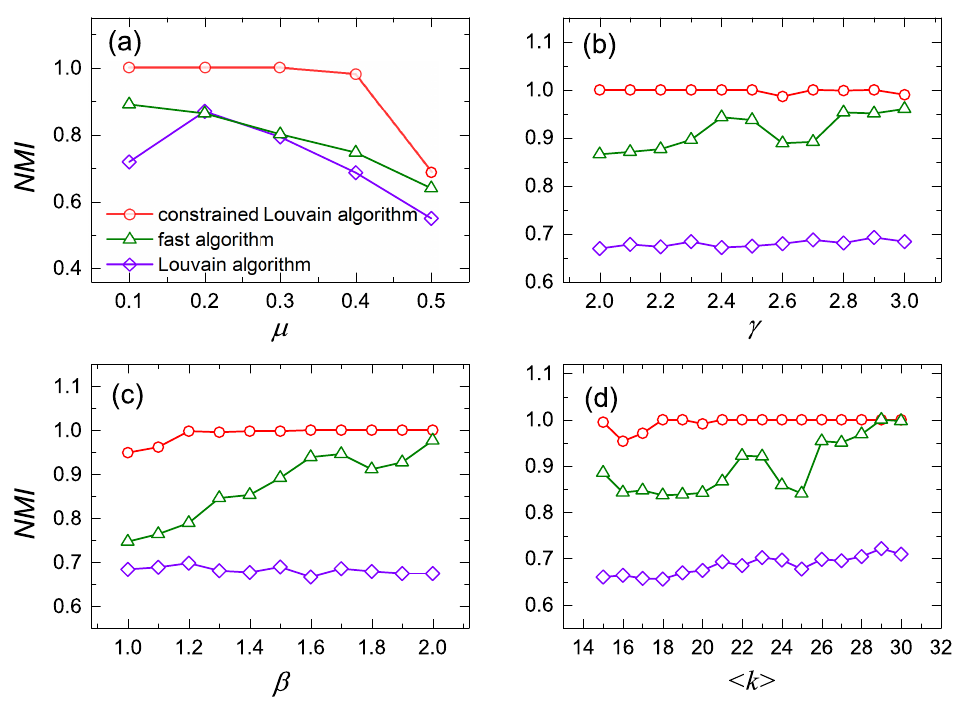
Figure 3. The NMI values of the constrained Louvain algorithm with F 2, the classical Louvain algorithm with F 2 and the Newman’s fast algorithm averaged on the 100 LFR networks with N = 1000. ( a ) µ is changed when γ = 2.5, β = 1.5 and (cid:104) k (cid:105) = 20. ( b ) γ is changed when µ = 0.3, β = 1.5 and (cid:104) k (cid:105) = 20. ( c ) β is changed when µ = 0.3, γ = 2.5 and (cid:104) k (cid:105) = 20. ( d ) (cid:104) k (cid:105) is changed when µ = 0.3, γ = 2.5 and β =